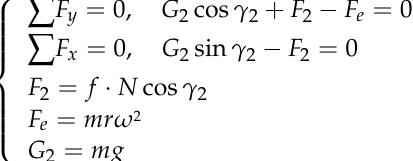
Figure 7. Analysis of seed protection process.